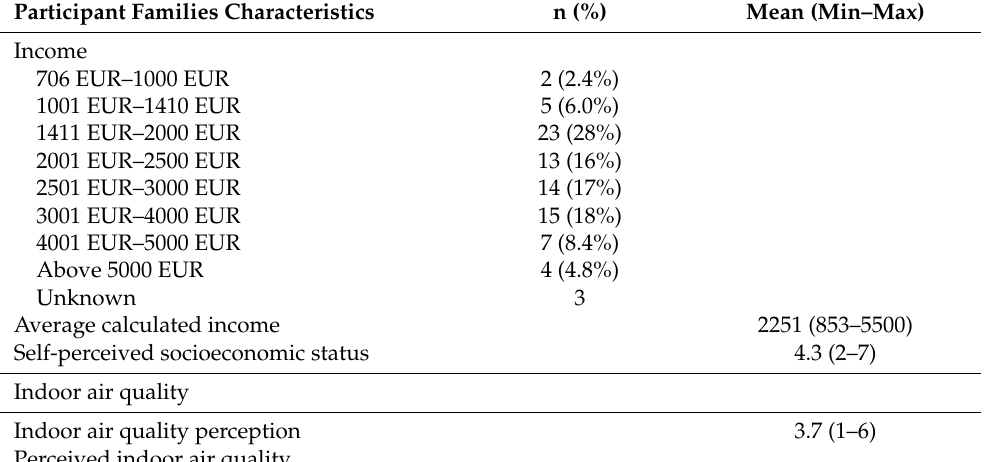
Table 4. Socioeconomic, thermal preference and indoor air quality status. Participant Families